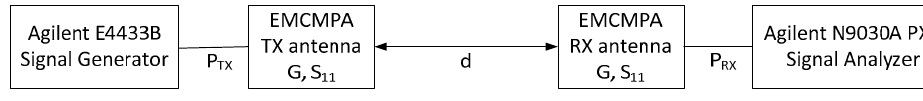
Figure 11. P RX configuration test setup.